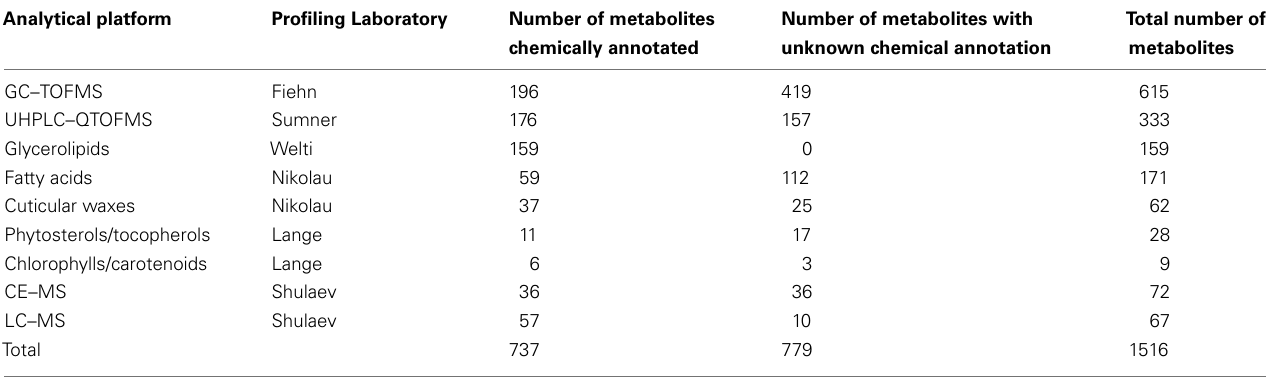
Table 1 | Summary of metabolites/compounds identified by the analytical laboratories in theArabidopsis Metabolomics Consortium.